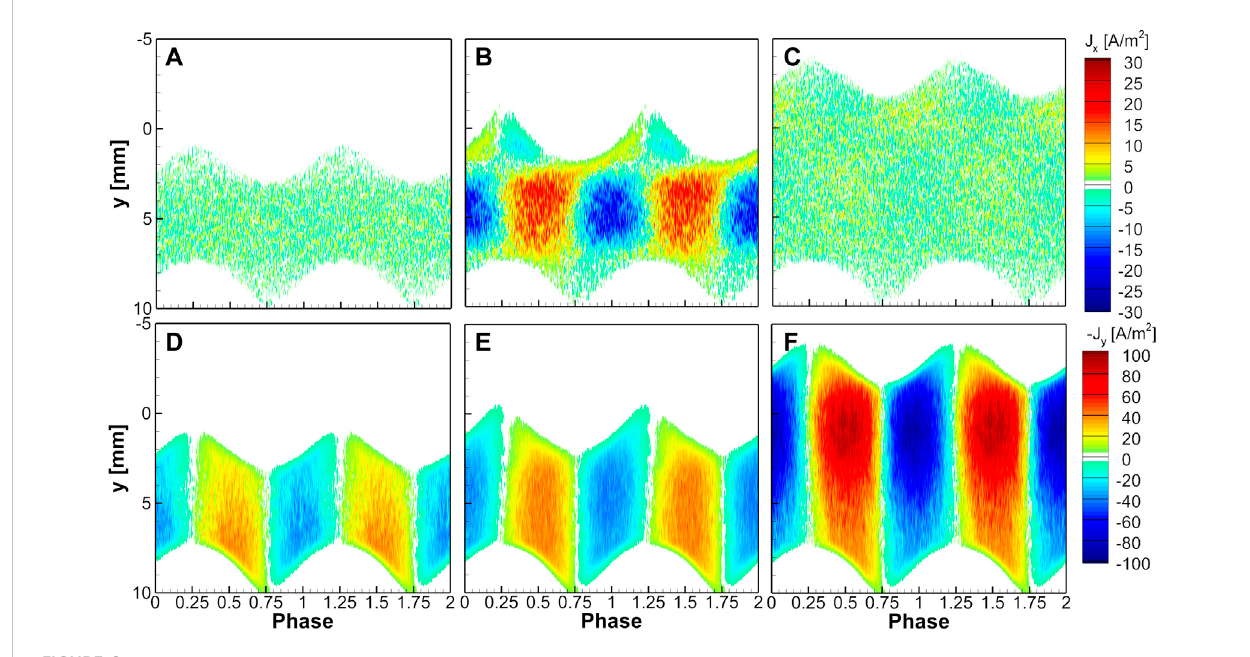
FIGURE 6 The phase-resolved electron current density for the conditions in Figure 3F for two RF periods. The electron current density (A) – (C) in the x -direction and (D) – (F) in the negative y -direction over the y -directional spatial positions at (A) , (D) x = − 8 mm, (B) , (E) x = − 3 mm, and (C) , (F) x =